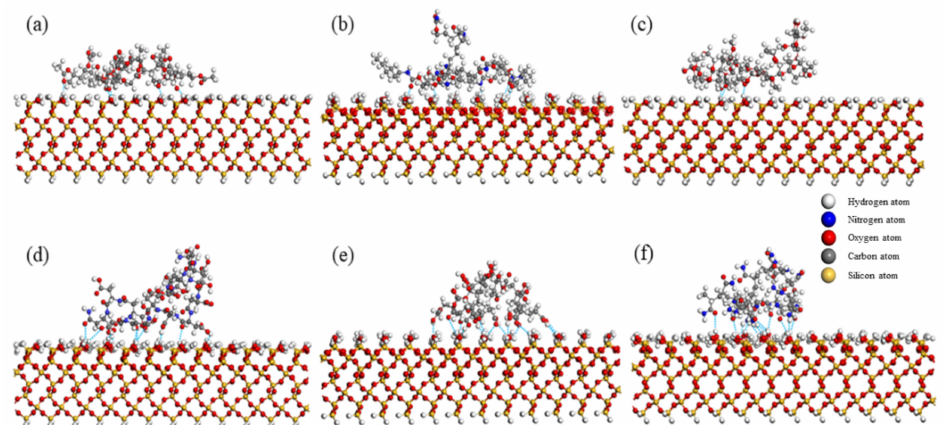
Figure 2. Pictures of polymer molecules adsorbed on a quartz surface, with hydrogen bonds shown in dashed lines. ( a ) PVAc, ( b ) PU, ( c ) HPMC, ( d ) PASP, ( e ) PAA, ( f )